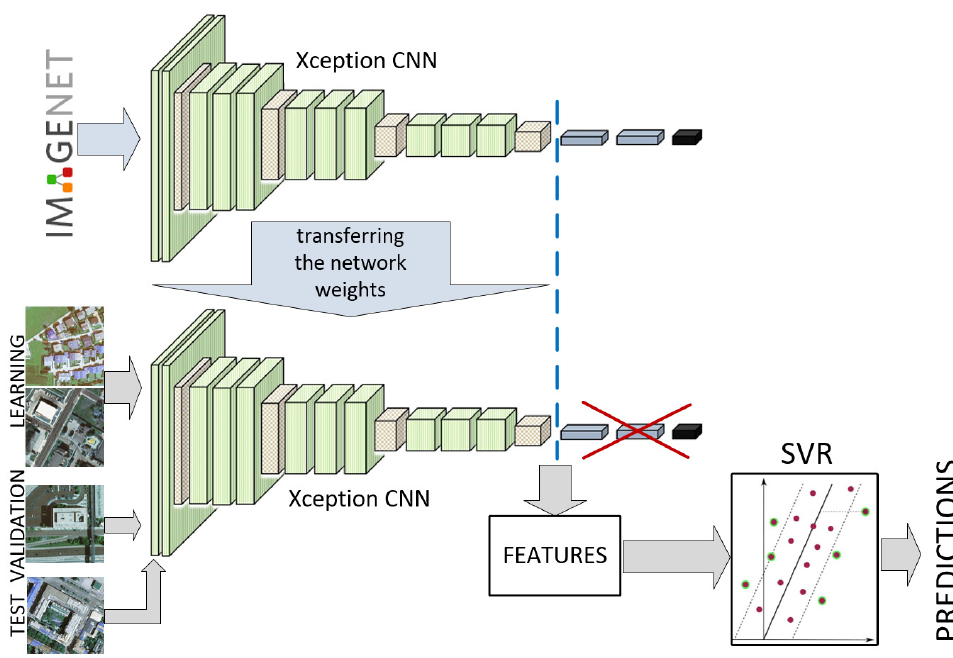
Figure 7. Hybrid architecture—Xception (feature extraction) + SVR (regression).